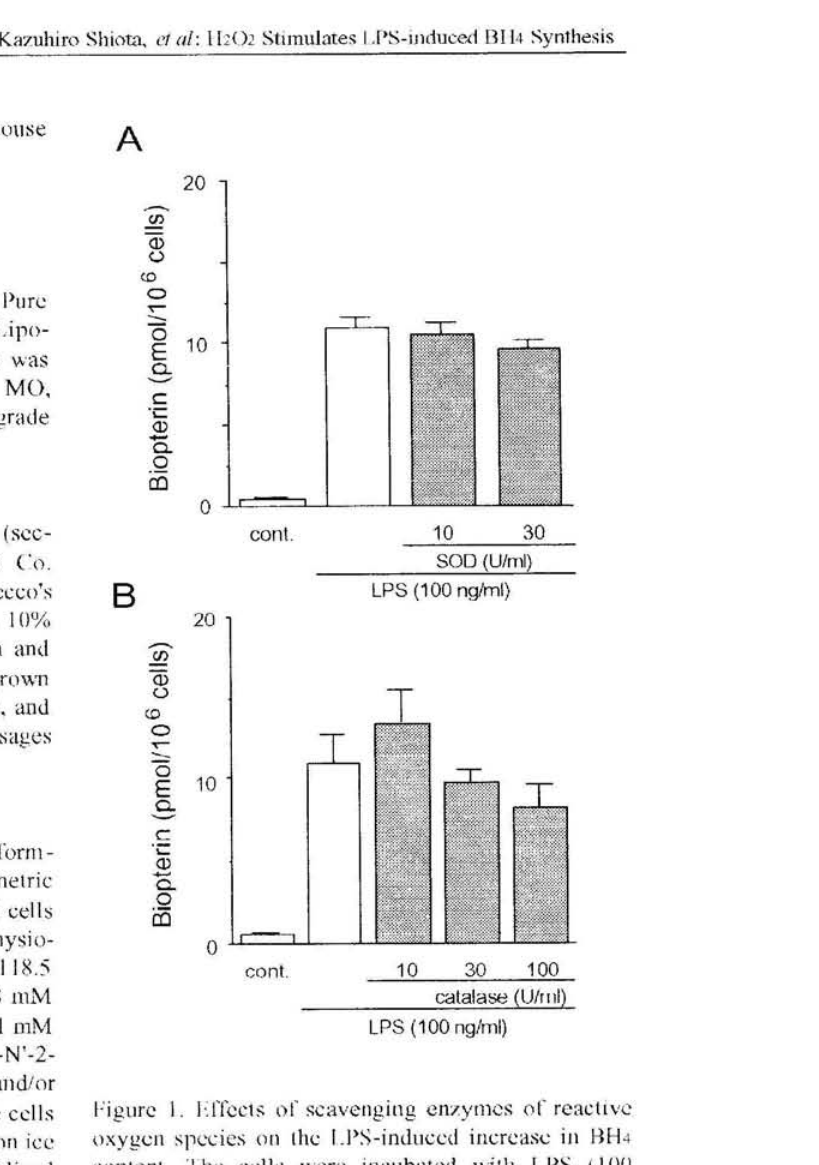
figure l. ITfects of scavenging enzymes of reactive oxygen species on the I.PS-induecd increase in BH4 content. The cells were incubated with I PS (100 ng/ml) in the presence or absence of SOD (A) or eata- lase (B) for 12 h. Values are the means ± S.L.M. of 4